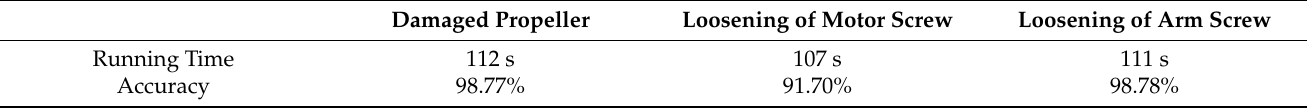
Table 6. The best single fault kNN classification model based on time-frequency domain data analysis.